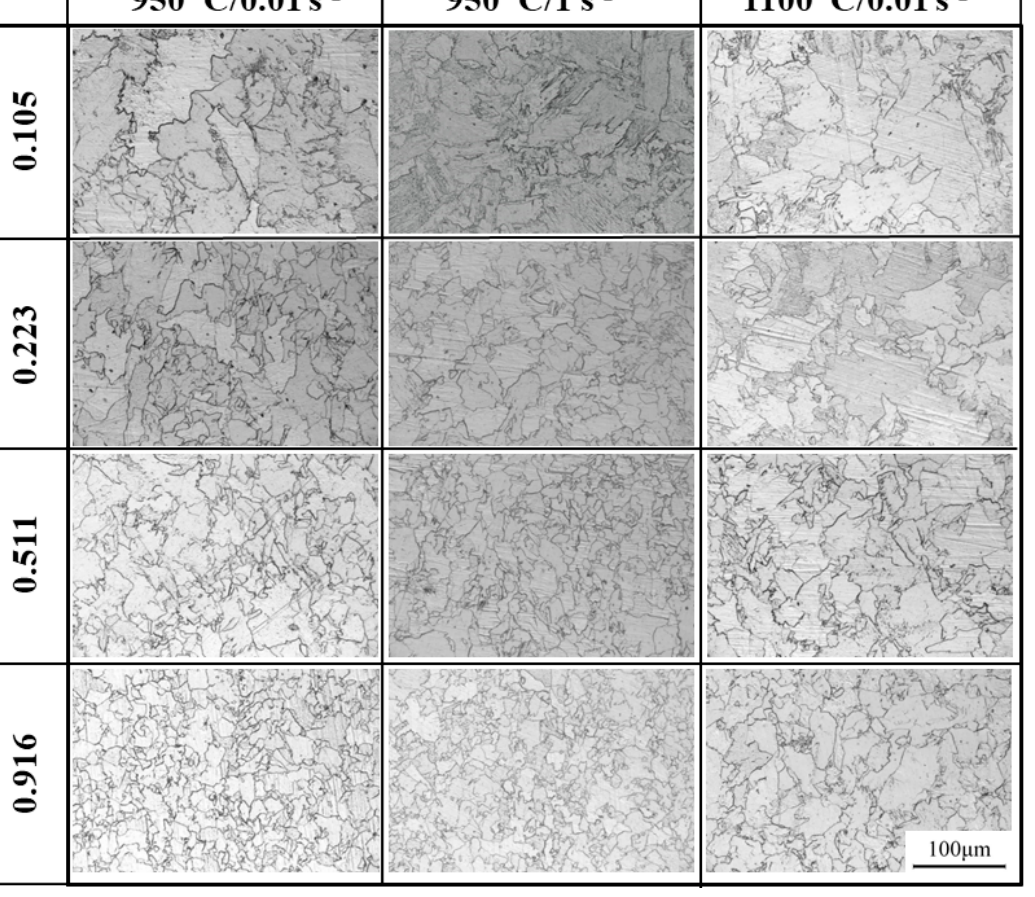
Figure 4. Metallography of the investigated steel under different deformation parameters.